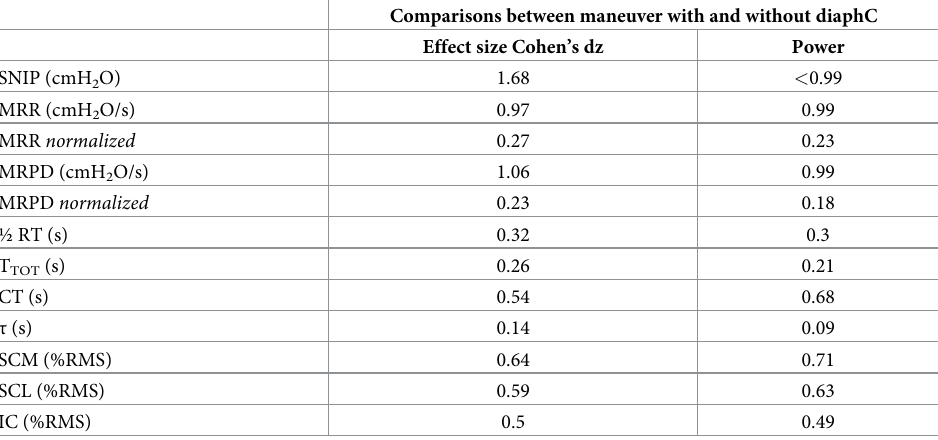
pressure obtained. The normalization of MRR by peak pressure (MRRnorm = (dP / dt) / P